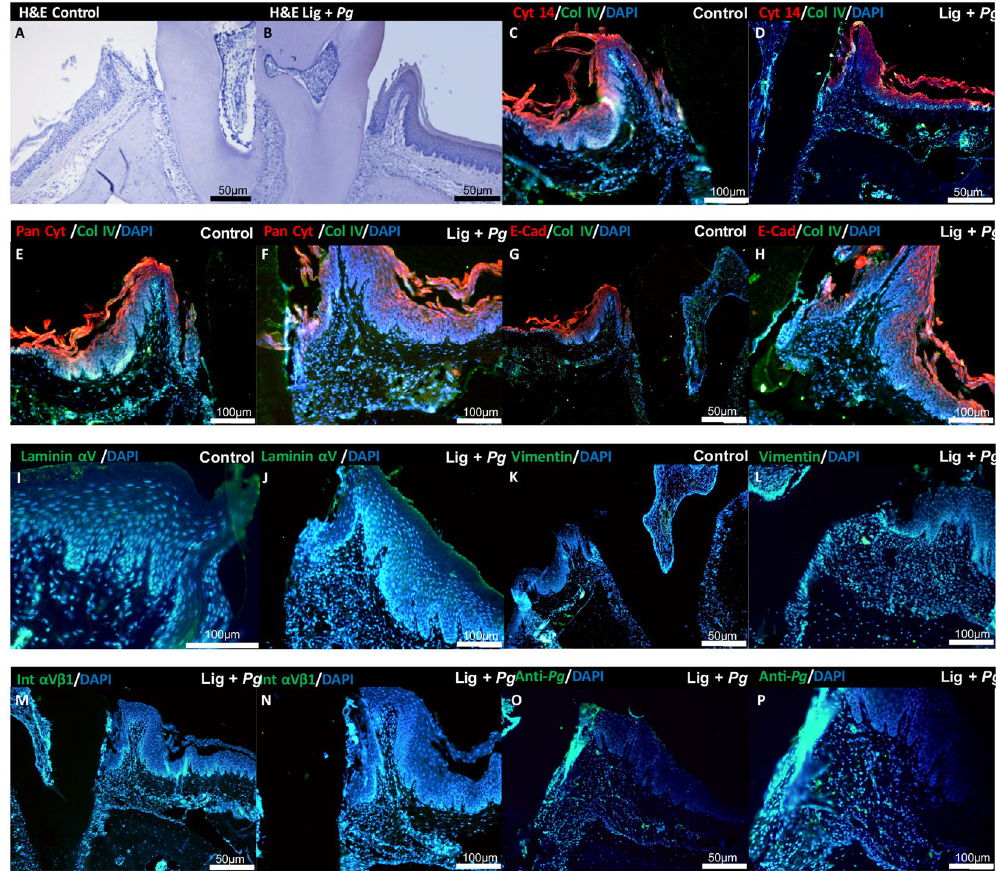
Figure 3. P. gingivalis -induced experimental periodontitis. ( A ) Histological hematoxylin-eosin staining of periodontium of non-treated site on the first molar of mice (Hematoxylin & Eosin) (10x magnification). ( B ) Morphological characteristics of periodontium of P. gingivalis ligature treated site on the first molar of mice (Hematoxylin & Eosin) (10x magnification). ( C – H ) Immunofluorescence staining for localization of Cytokeratin 14, Pan Cytokeratin and E-cadherin expression in epithelial tissue (red) and Collagen IV expression (green) in the periodontium (10x magnification). ( I – P ) Immunofluorescence staining for localization of Integrin β 1, vimentin, laminin α 5 and anti- P. gingivalis expression in the periodontium (green) at diseased site (10x magnification: I – M and O ; 20x magnification: N , P ). In all immunofluorescence images, nucleus has been stained by DAPI in